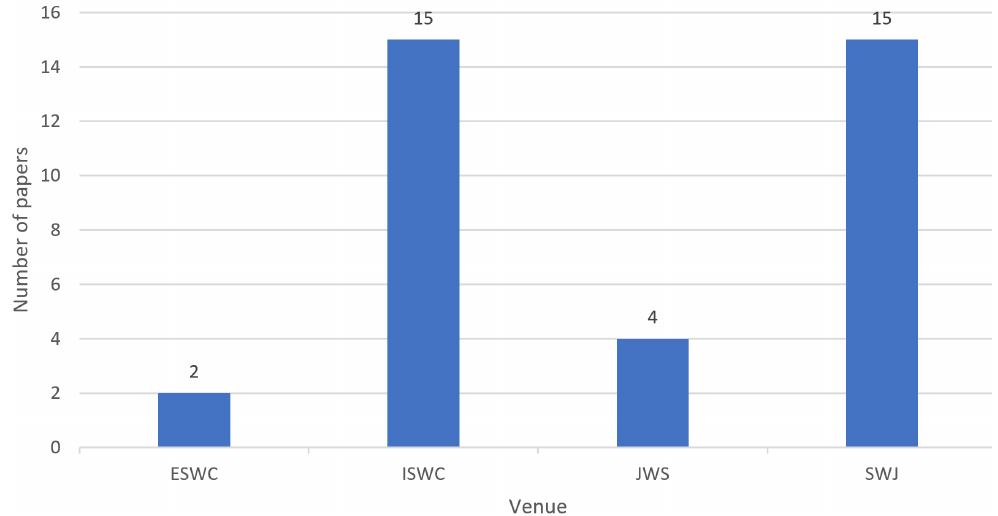
Figure 2. Number of papers per